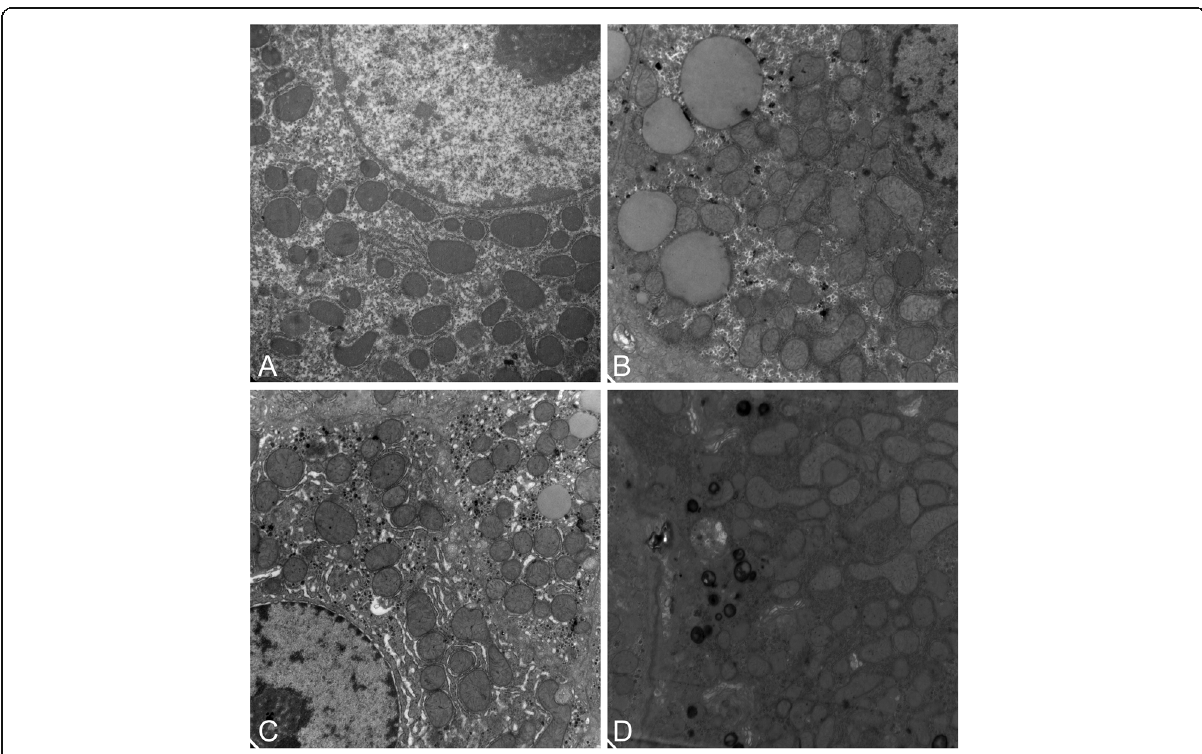
Fig. 6 Typical mitochondria changes of liver under transmission electron microscopy. a The size of mitochondria was uniformly sized in the control group. b Mitochondrial matrix was swollen in the HFD group. c Compared with the HFD group, mitochondrial ultrastructural damage was reversed by BRL37344 in the HFD + β 3-AGO group. d The HFD + β 3-ANT group showed more severe mitochondrial swelling and increased lysosomes than that of the HFD group. The magnification was 15,000× in each image (each group, n =